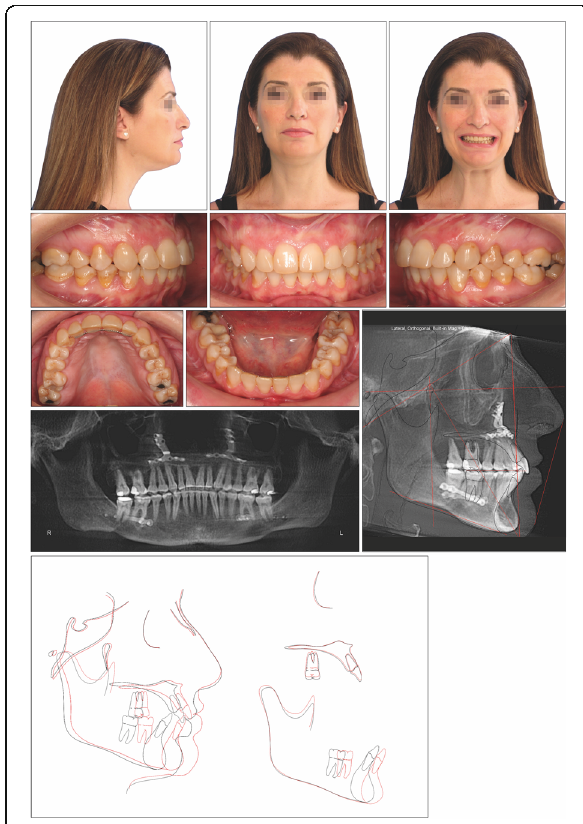
Fig. 3 Posttreatment records and superimposition of tracings before treatment ( black line ) and after treatment ( red line ) of patient